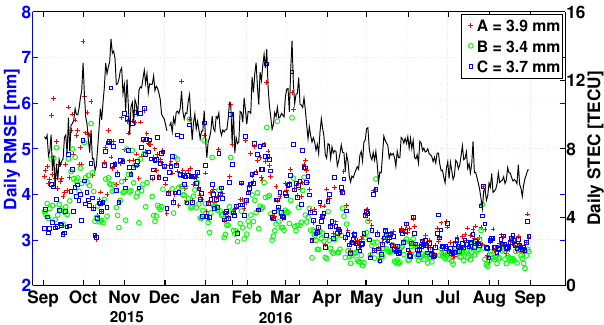
Figure 13. Daily RMSEs of the ionosphere-free carrier phase resid- uals and the daily average STEC derived from Swarm C over all GPS satellites for 1 year of data from DoY 245, 2015 to DoY 244, 2016.